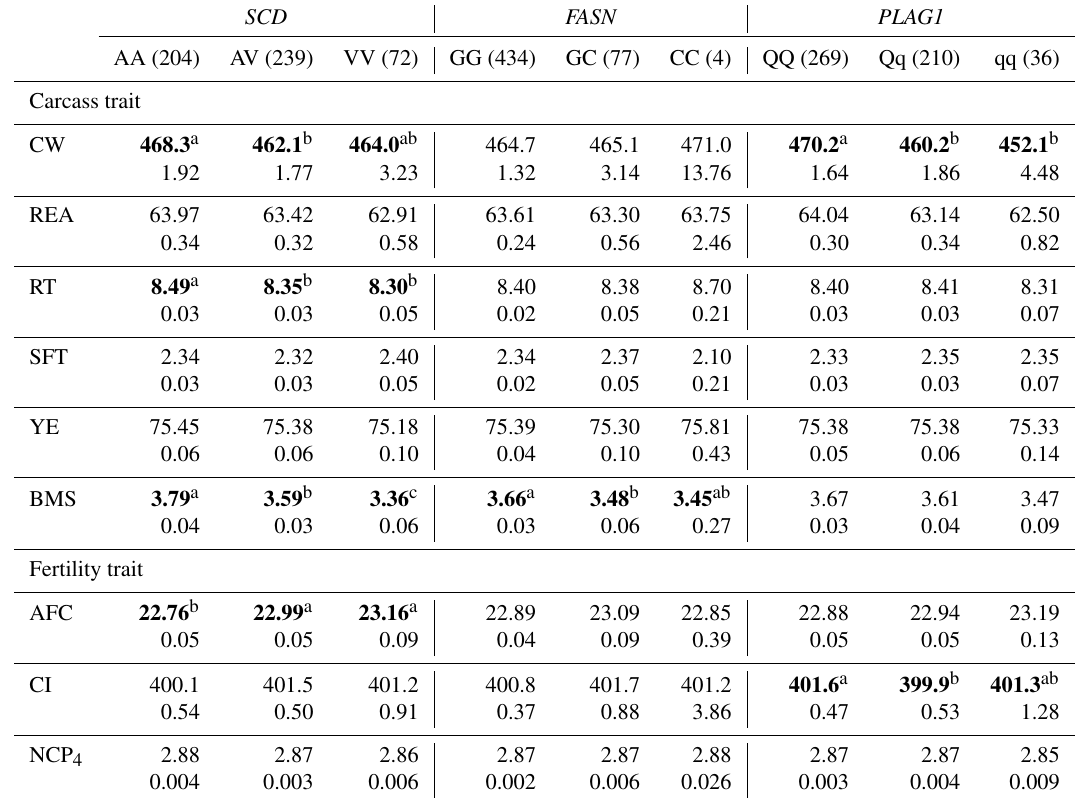
Table 5. The effect of the markers within SCD , FASN , and PLAG1 genes on carcass and fertility traits in the Japanese Black cattle population ( n =